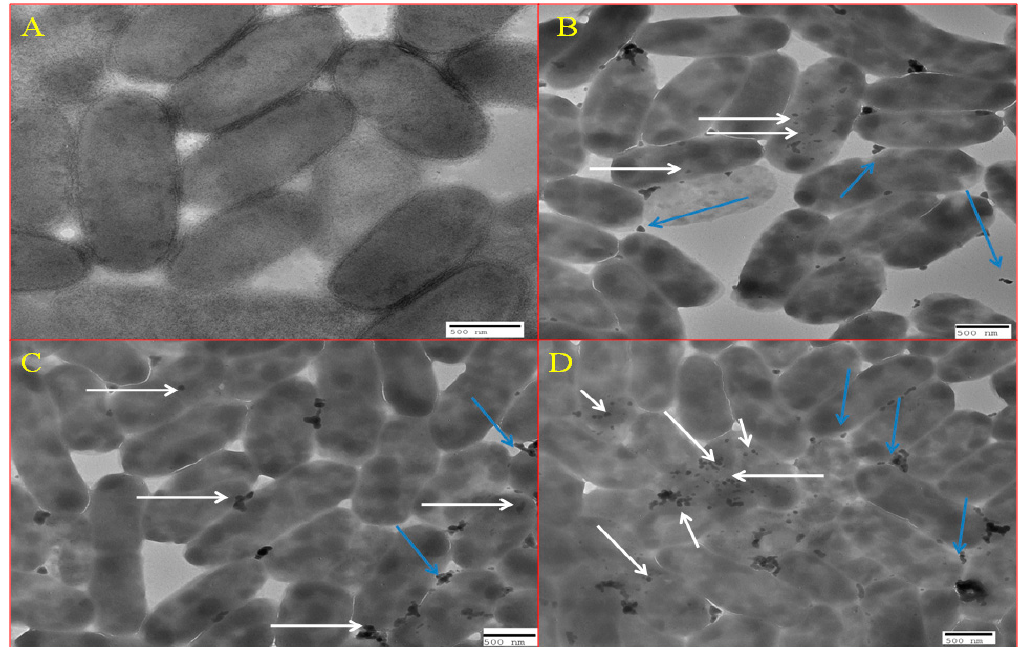
Figure 10. TEM showing internalization of ZnO NPs. ( A ) Control, ( B ) at 100 µg/mL of ZnO, ( C ) at 200 µg/mL of ZnO, and ( D ) 300 µg/mL of ZnO NPs. White arrows marks the internalized nanoparticles whereas blue arrow marks the nanoparticles which are outside the cells.